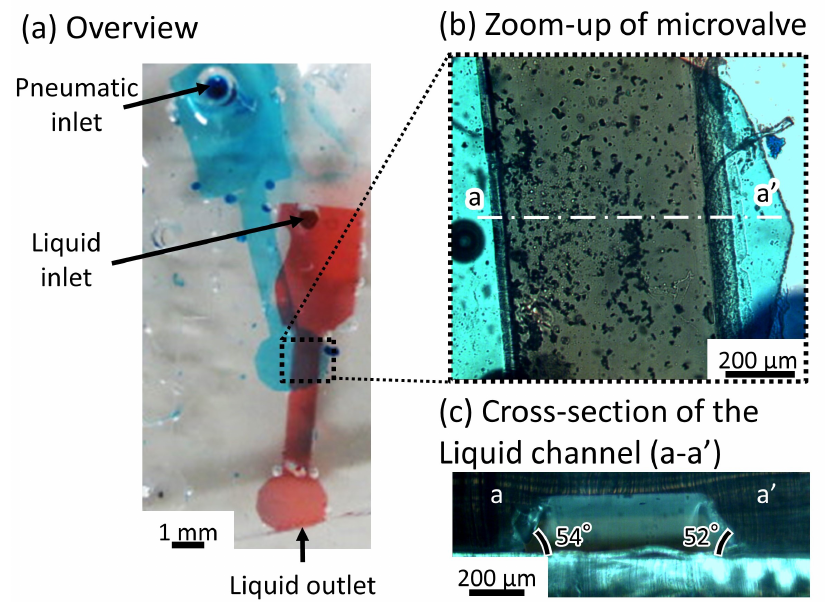
Figure 7. Microfluidic device with the microvalve for a tall microchannel. ( a ) Overview of the microfluidic device; ( b ) zoom-up of the microvalve; ( c ) cross-section of the liquid channel